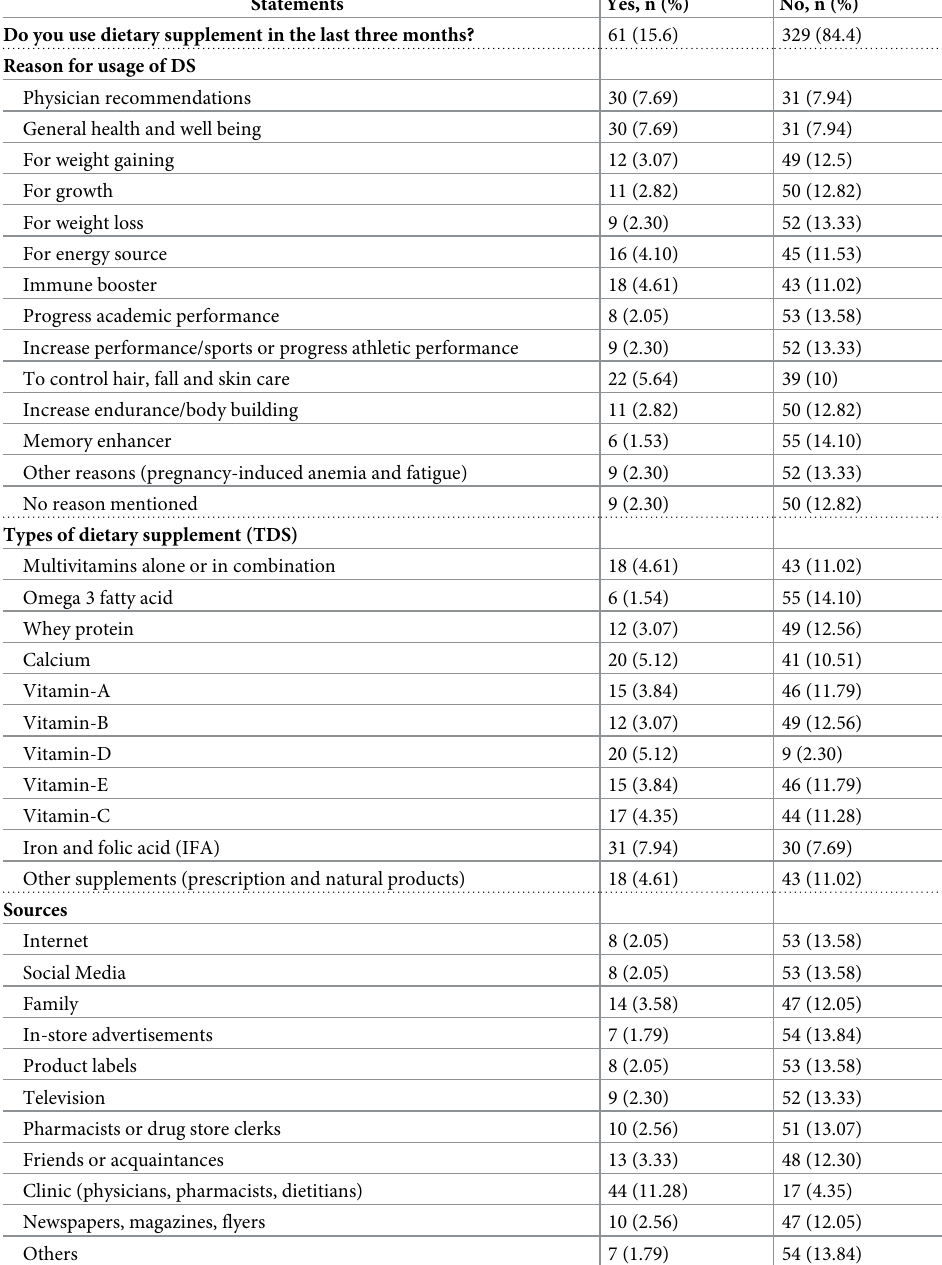
Table 5. Reasons, types and sources for using dietary supplements among study